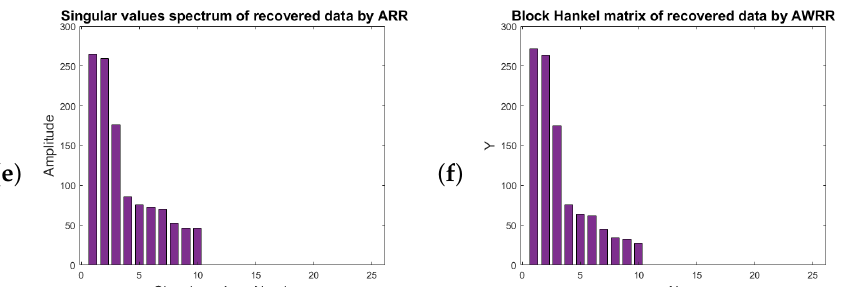
Figure 10. The spectrum of the first 25 singular values of the block Hankel matrices for frequency slice of 50 Hz for ( a ) clean and complete data, ( b ) data with SNR = 2 and 50% killed traces, ( c ) data recovered by TRR, ( d ) data recovered by WRR, ( e ) data recovered by ARR, ( f ) data recovered by